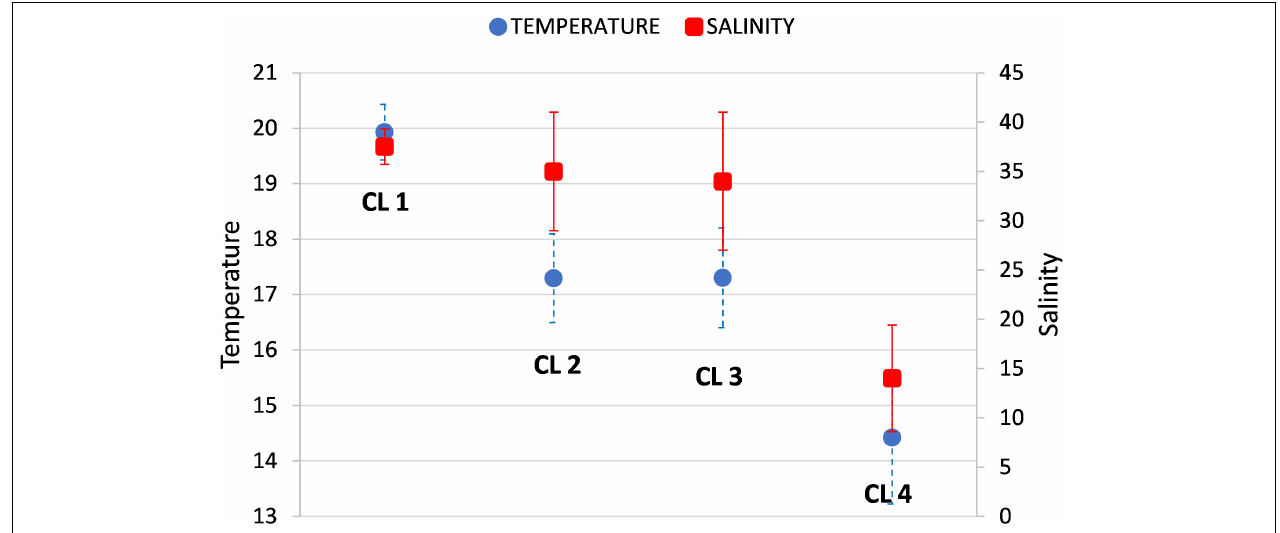
FIGURE 1 | Characterization of clusters in relation to temperature and